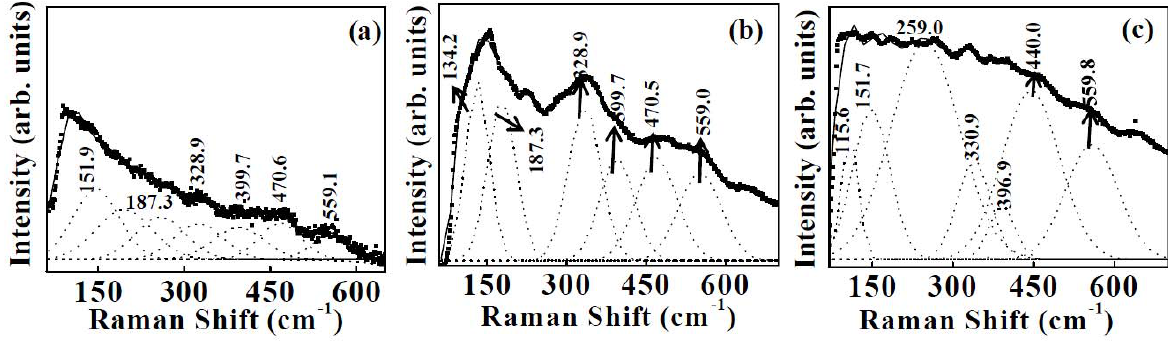
O coating, ( b ) 2 3 O coating. 2 3